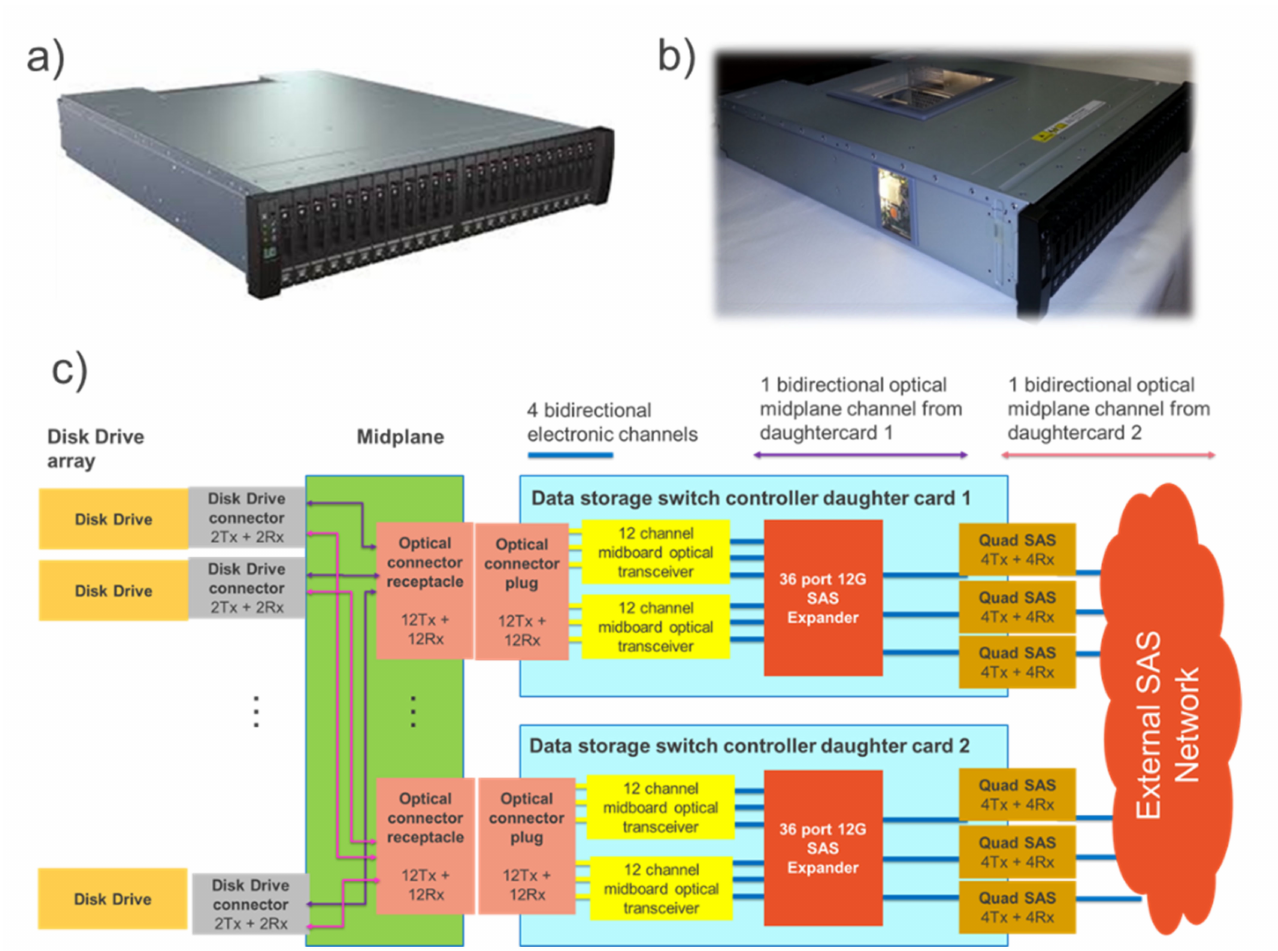
Figure 7. Fully optically enabled SAS data storage system (ThunderValley2): ( a ) standard 2U24 OneStor storage array system, ( b ) photo of ThunderValley2 system [12], ( c ) schematic view of fully optically enabled SAS storage